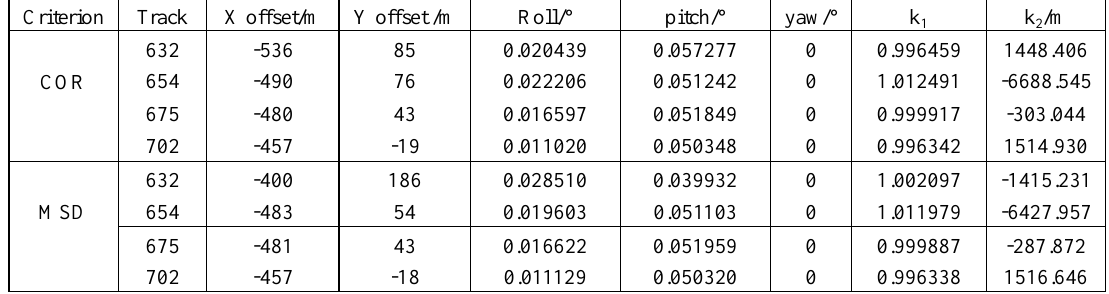
Table 2. Comparison of COR and MSD criterion obtained calibration parameters.